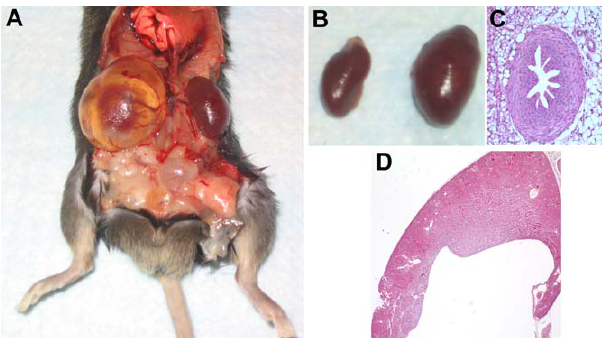
Figure 2. Anatomy and Histology of Mouse Kidneys